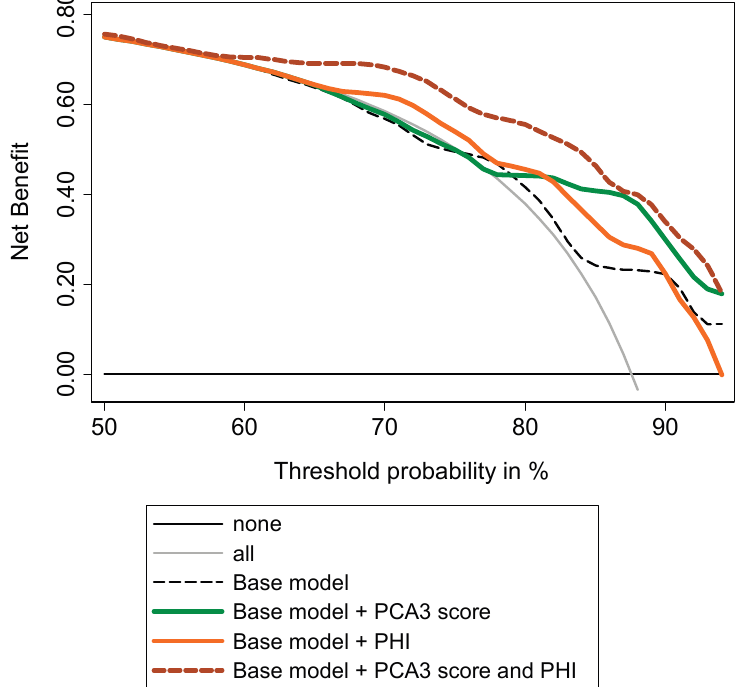
Figure 6. Evaluation of the ability of PHI and PCA3 score to predict tumor volume ≥ 0.5 mL using decision curve analysis. Base model: age, DRE findings, total serum PSA, and Gleason sum at